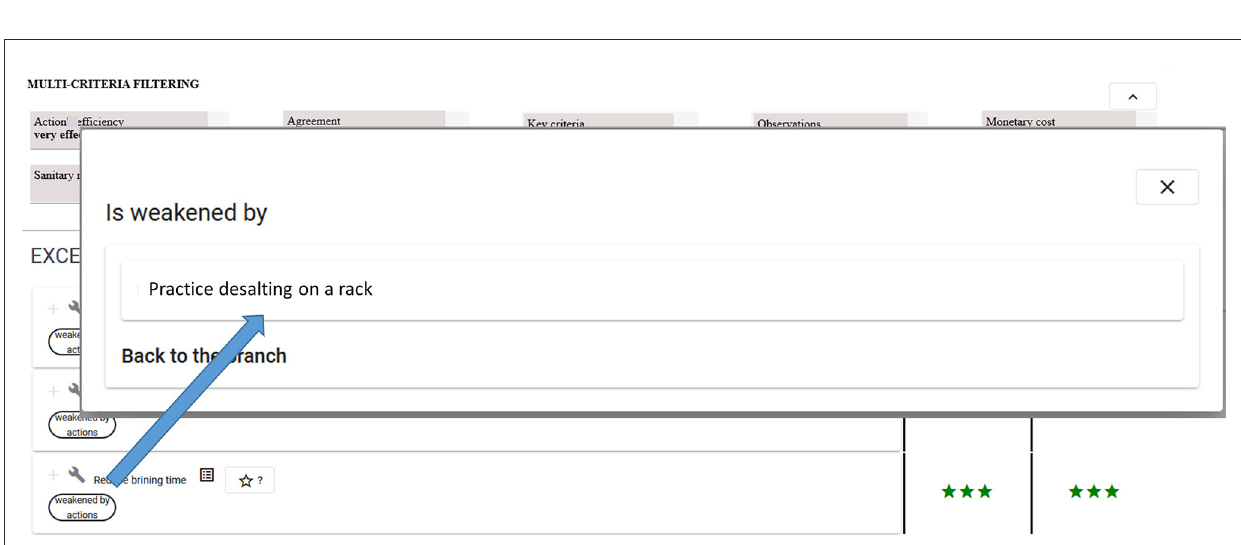
FIGURE9 MCDSS action view showing a list of actions related to the decision tree associated with the Excessive salting situation of interest which could potentially weaken the recommended action. The three stars indicate the action’s efficiency is “very